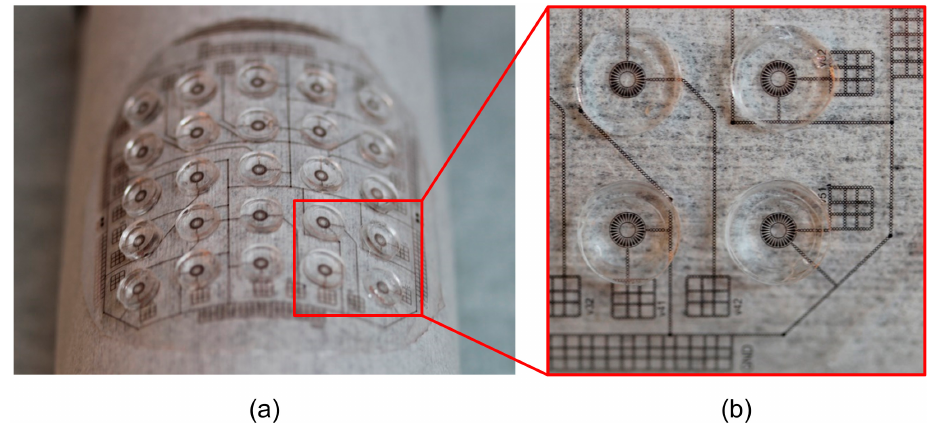
Figure 4. Photographs of the fully assembled flexible electrowetting array on PDMS substrate showing: ( a ) the full 5 × 5 array wrapped on the surface of a cylinder and ( b ), a close up of one section of the array, showing individual electrowetting wells as well as traces and contact pads for applying voltage.